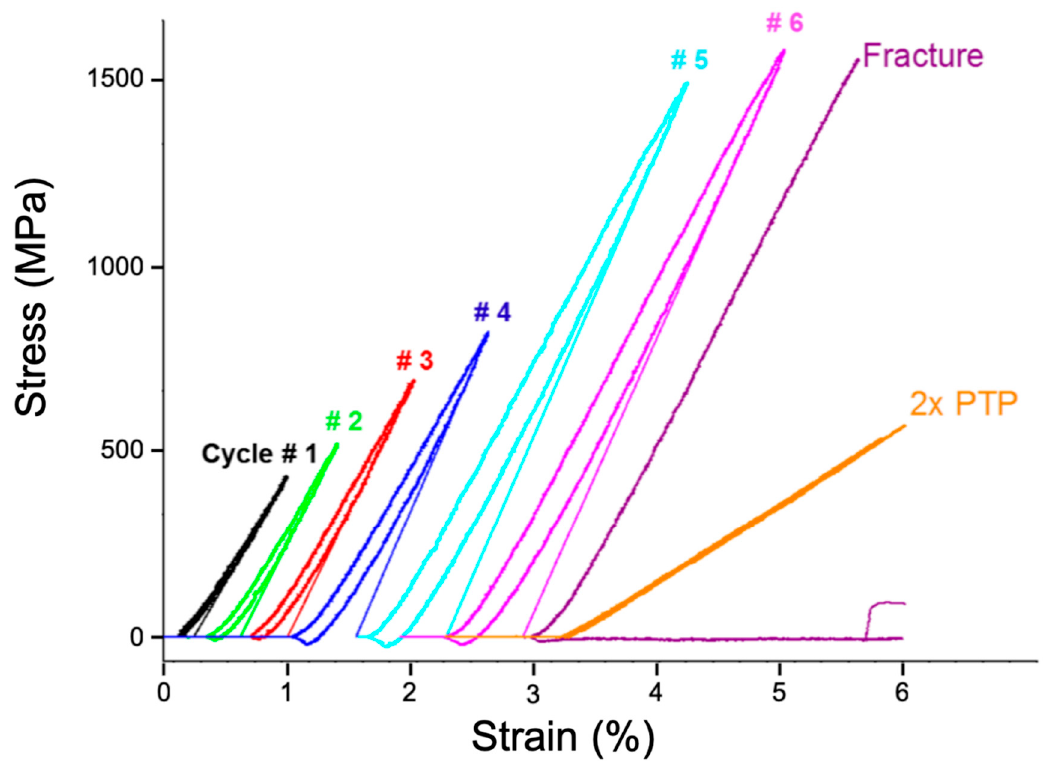
Figure 3. Stress–strain response during cyclic loading–unloading experiments after drift correction showing a significant Bauschinger effect. The curves in orange show the response of the push-to-pull device, which are fully overlapping during loading–unloading, indicating a full elastic response of the PTP device and the stability after drift correction.